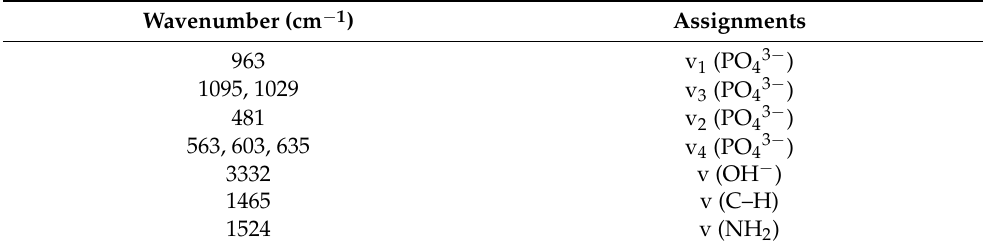
Table 1. IR wavenumber (cm − 1 ) assignments of HApCh sample [32,33].